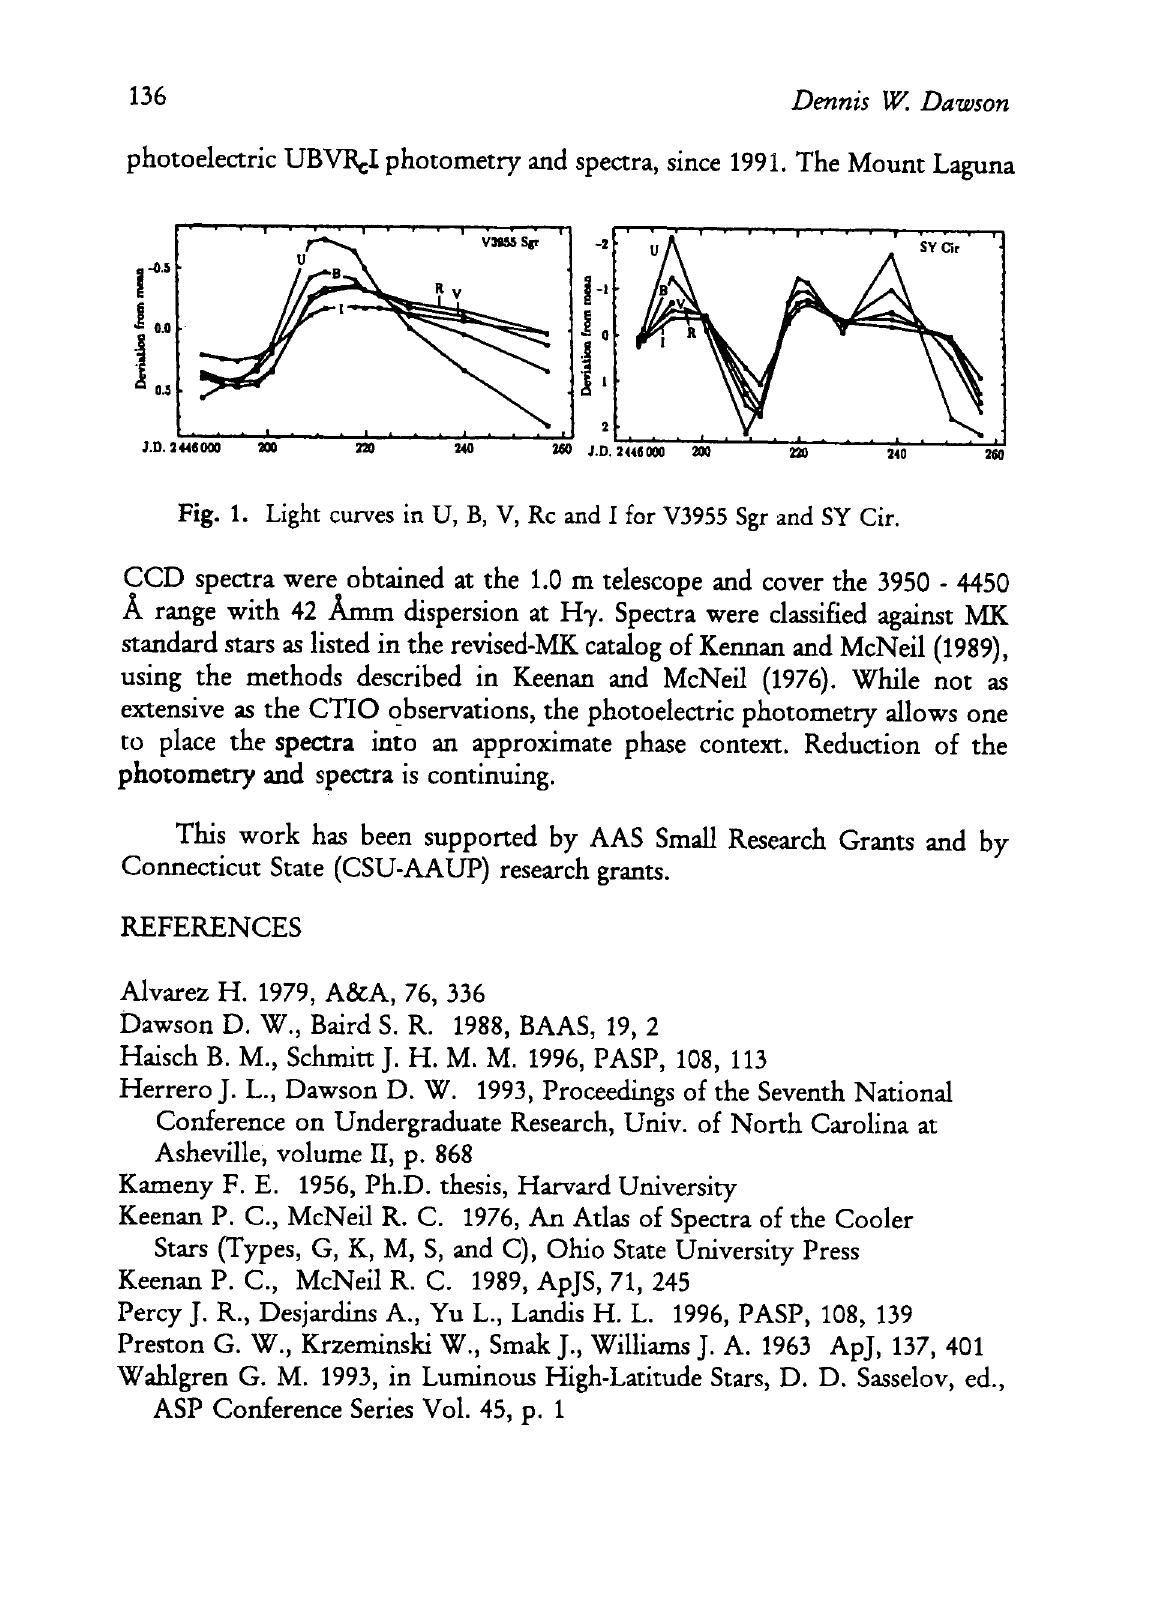
Fig. 1. Light curves in U, Β, V, Rc and I for V3955 Sgr and SY Cir. CCD spectra were obtained at the 1.0 m telescope and cover the 3950 - 4450 A range with 42 Amm dispersion at Ηγ. Spectra were classified against MK standard stars as listed in the revised-MK catalog of Kennan and McNeil (1989), using the methods described in Keenan and McNeil (1976). While not as extensive as the CTIO observations, the photoelectric photometry allows one to place the spectra into an approximate phase context. Reduction of the photometry and spectra is